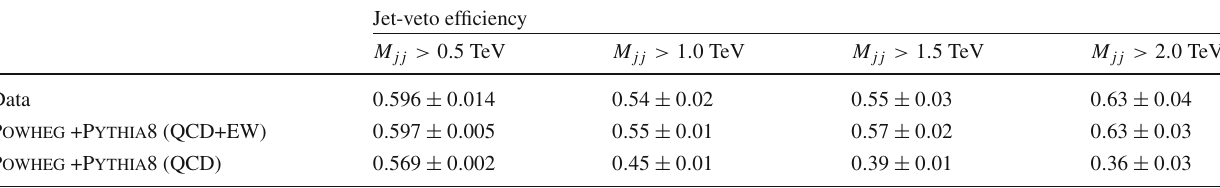
Table 8 Jet-veto efficiency for each M jj threshold compared to Powheg + Pythia8 QCD+EW and QCD W jj simulations. The uncertainties comprise statistical and systematic components added in quadrature Jet-veto efficiency M jj > 0 . 5 TeV M jj > 1 . 0